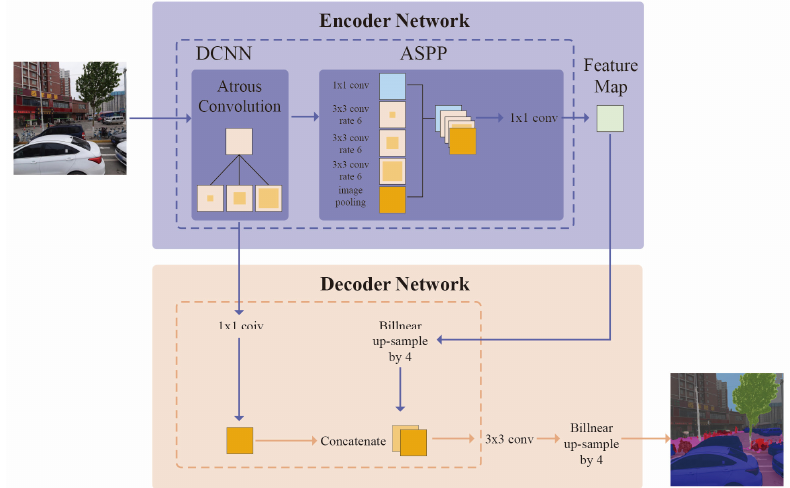
Figure 7. Structure of the encoder-decoder networks in the DeepLab v3+ model.